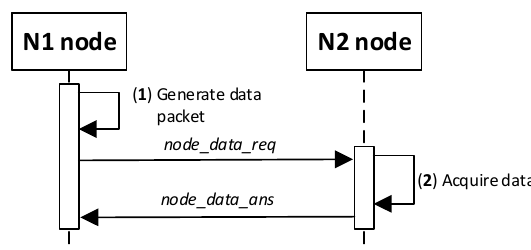
Figure 30. The way the N1 node and the N2 node work together during the data exchanging.